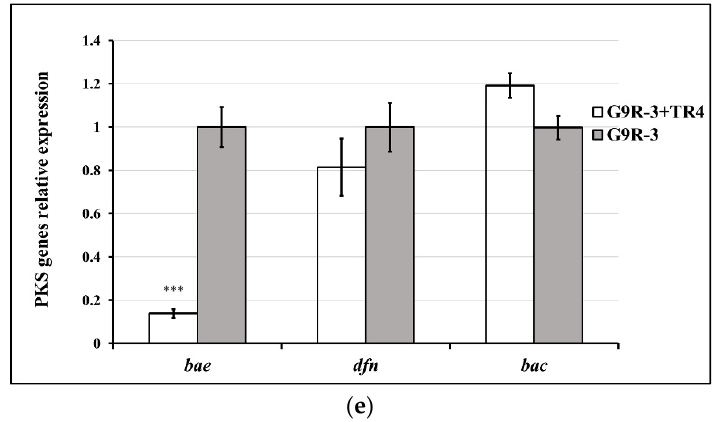
Figure 6. Biocontrol PKS gene ( mln , bae , dfn and bac ) expression profiles of five Bacillus strains: N67, YN1282-2, WBN06, HN04 and G9R-3. ( a – e ): each represent PKS gene’s expression profiles of N67, YN1282-2, WBN06, HN04 and G9R-3. The asterisk represents a significant difference in gene expression between single and dual-cultured (Student’s t -test: 0.01 < p < 0.05 “*”, p < 0.01 “**”, p < 0.001 “***”).